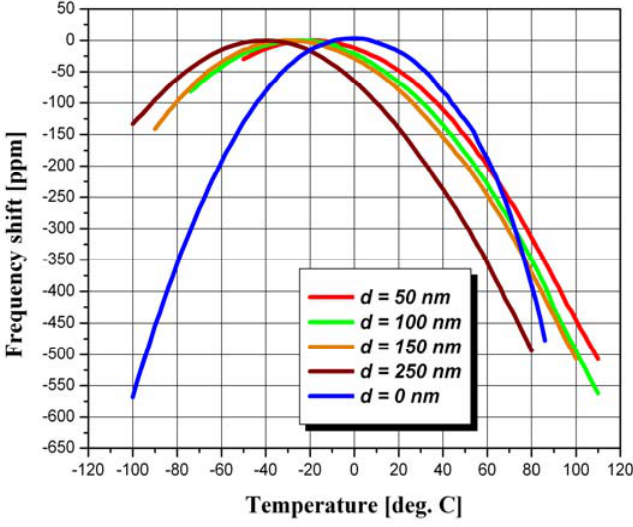
Figure 7. TFCs of HMDSO polymer coated RSAW sensors at 4 different film thicknesses compared to an uncoated sensor.